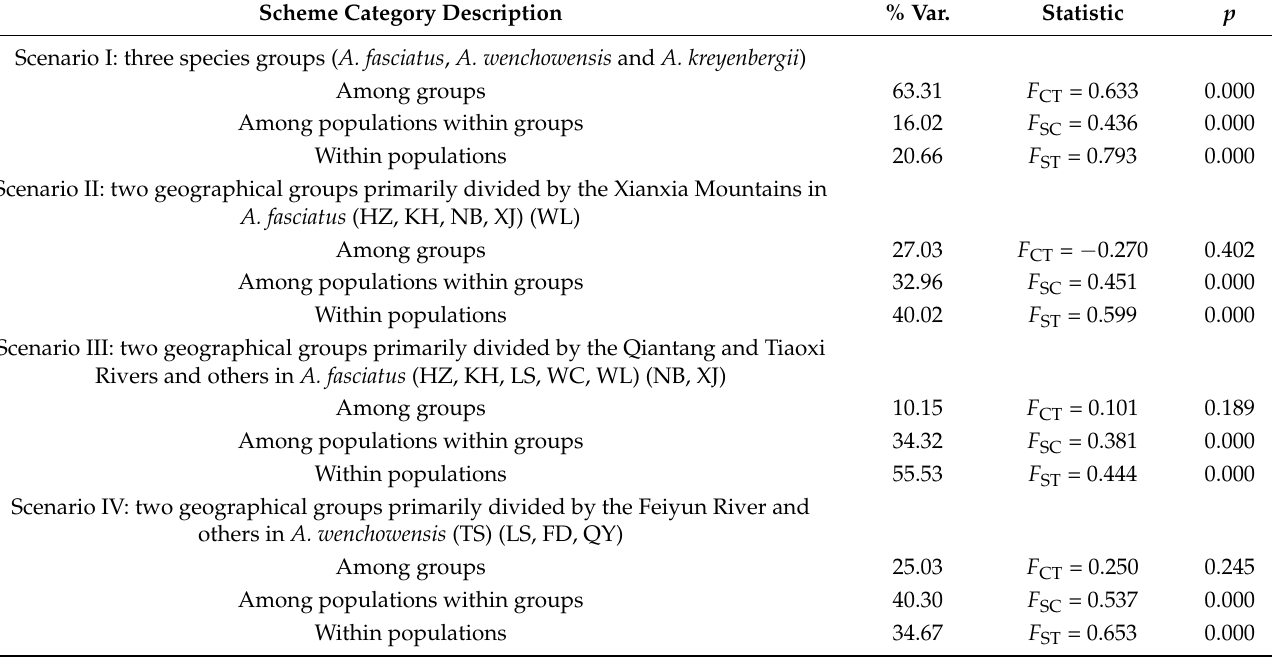
Table 3. Analysis of molecular variance (AMOVA) for Acrossocheilus based on the mtDNA cyt b + D-loop